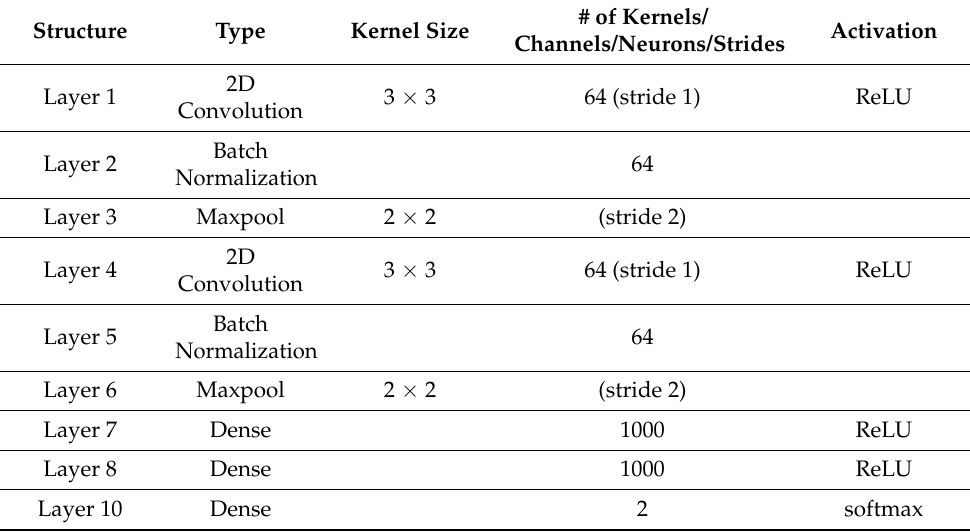
Figure 5. Network structure of FSFS-CNN. Table 2. Detailed network design for MG-CNN.